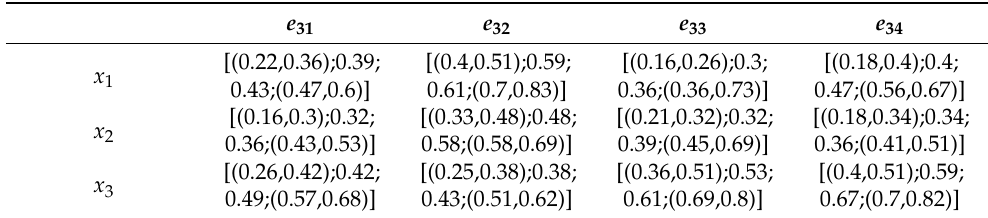
Table A16. The influencing factors of B 3 in the whole time period belong to the comprehensive evaluation value of different risks.